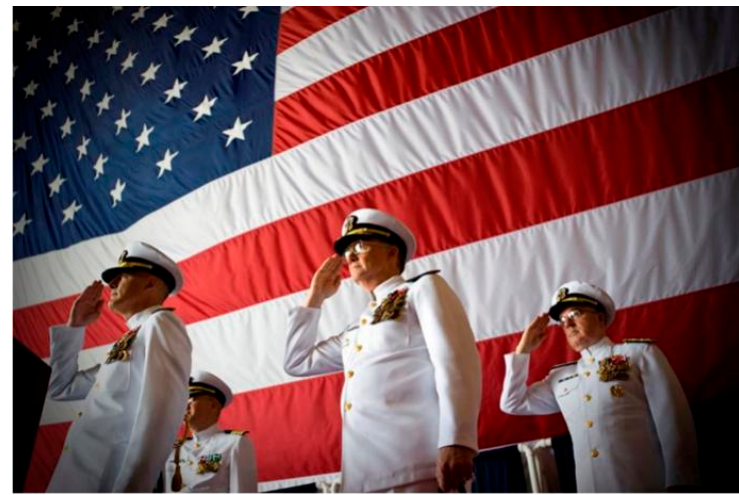
Figure A5. Stimulus Image for the National Security Message.